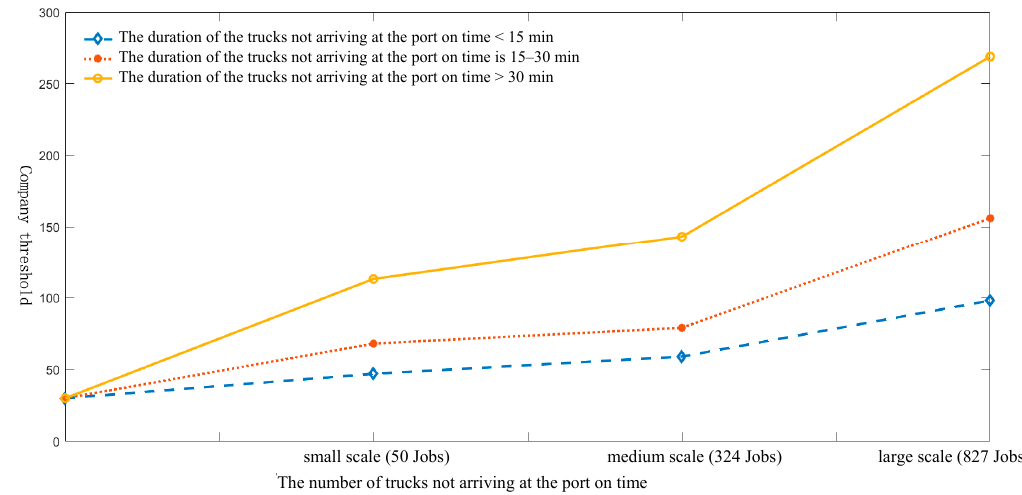
Figure 9. The impact of the truck’s failure to arrive at the port on time on the company’s